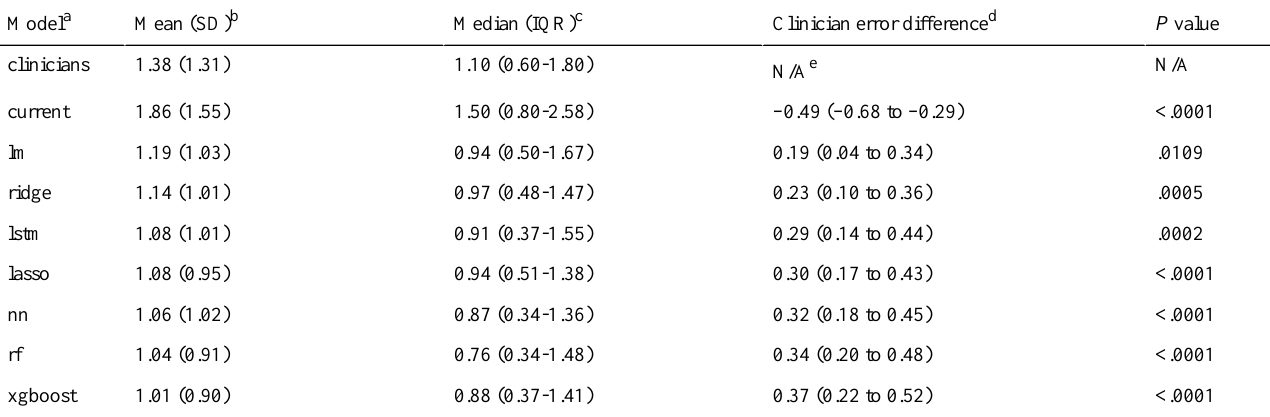
Table 2. Absolute errors of clinician and model predictions.